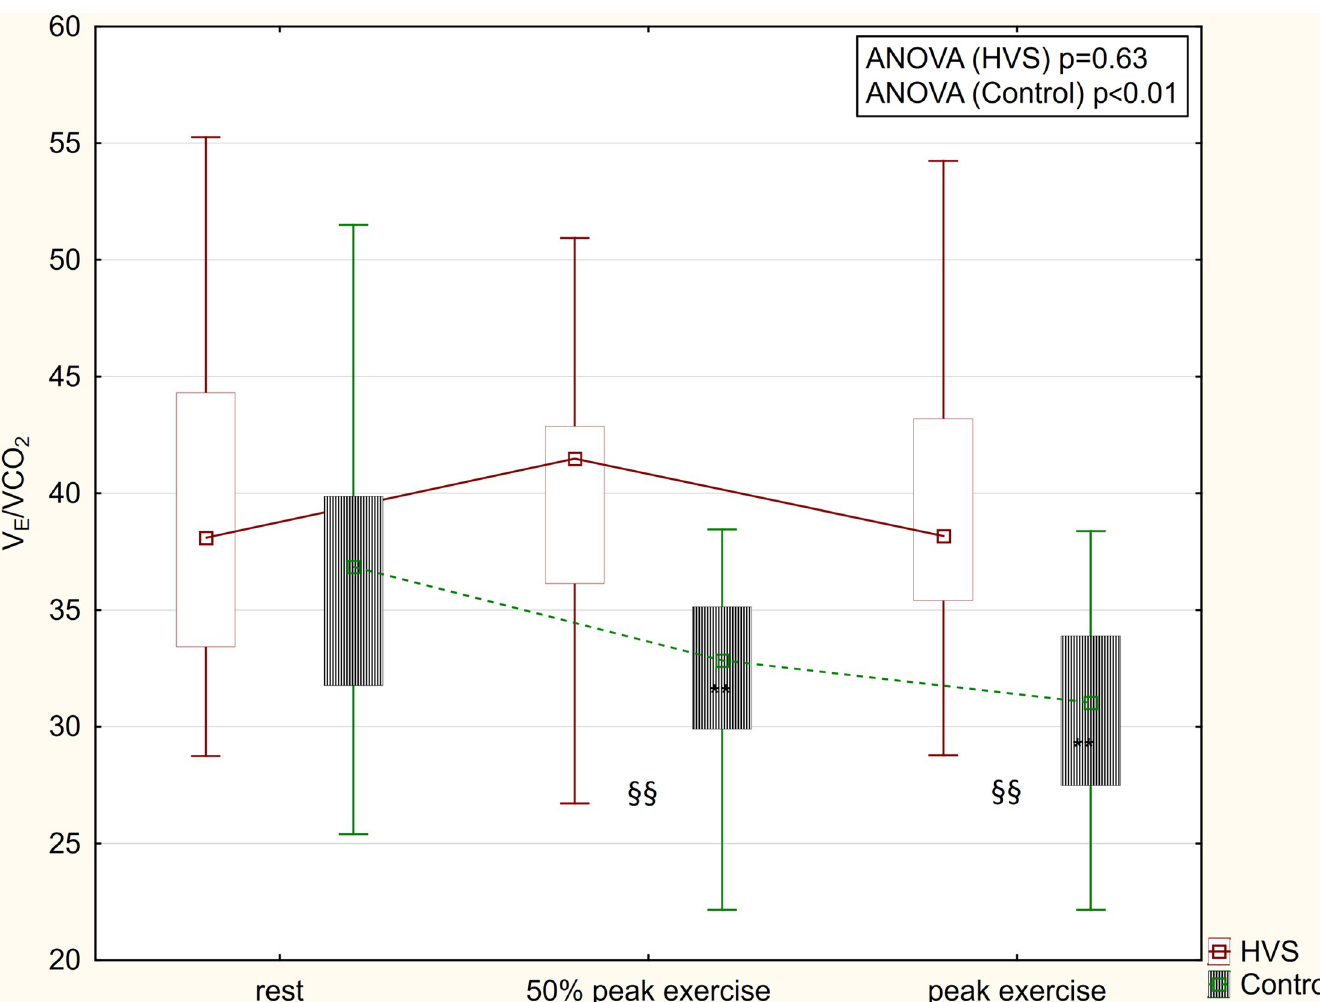
Fig 3. V E /VCO 2 changes during exercise. In contrast to patients with HVS, V E /VCO 2 decreased during exercise in controls. �� = p < 0.01 compared to rest; §§ = p < 0.01 HVS vs.